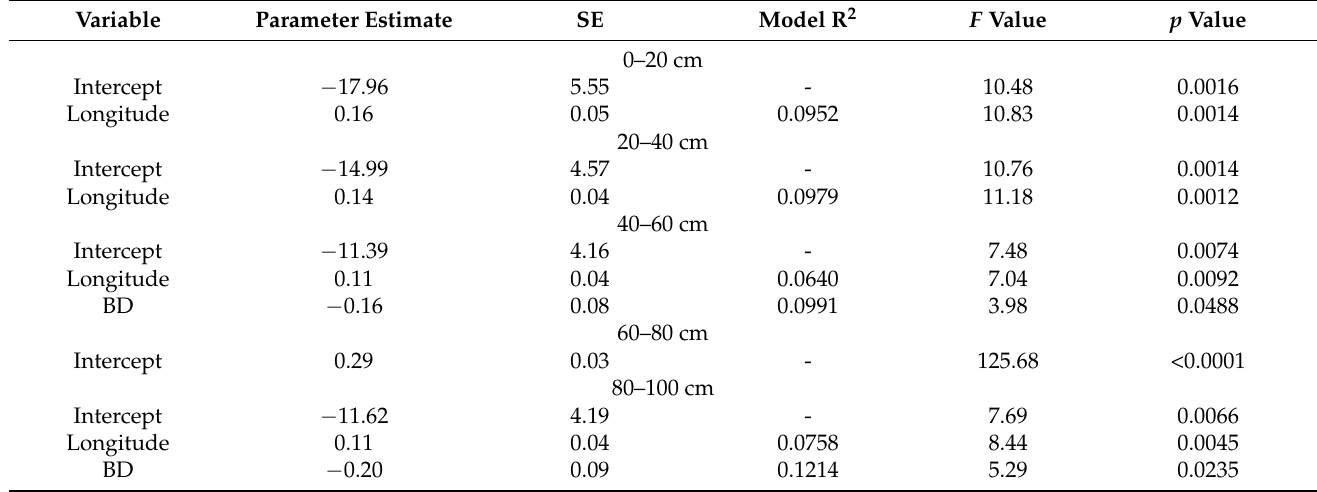
Table 4. Stepwise regression of surface topology and physicochemical property to total phosphorus stock in Udults soils at different depths for a secondary forest and Eucalypt ( Eucalyptus obliqua L’H é r.), Litchi ( Litchi chinensis Sonn., 1782), Masson pine ( Pinus massoniana Lamb.), and Slash pine ( Pinus elliottii Engelm.) plantations at Yunfu, Guangdong,